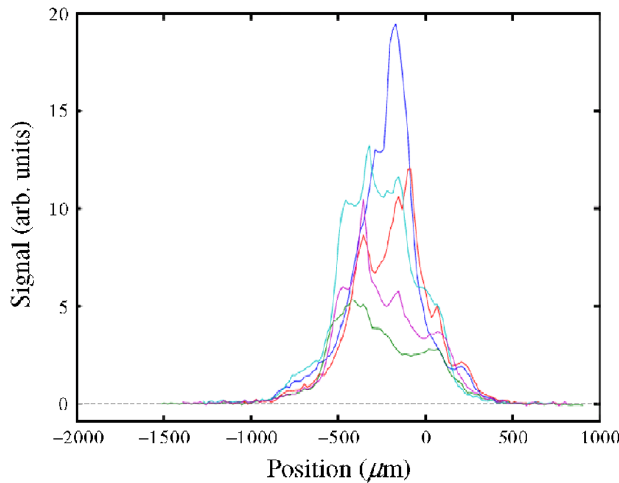
FIG. 42. (Color) OTR screen profile projections for five con- secutive beam pulses when the L1S rf phase is set at 50 degS off crest, in conditions of extreme compression.